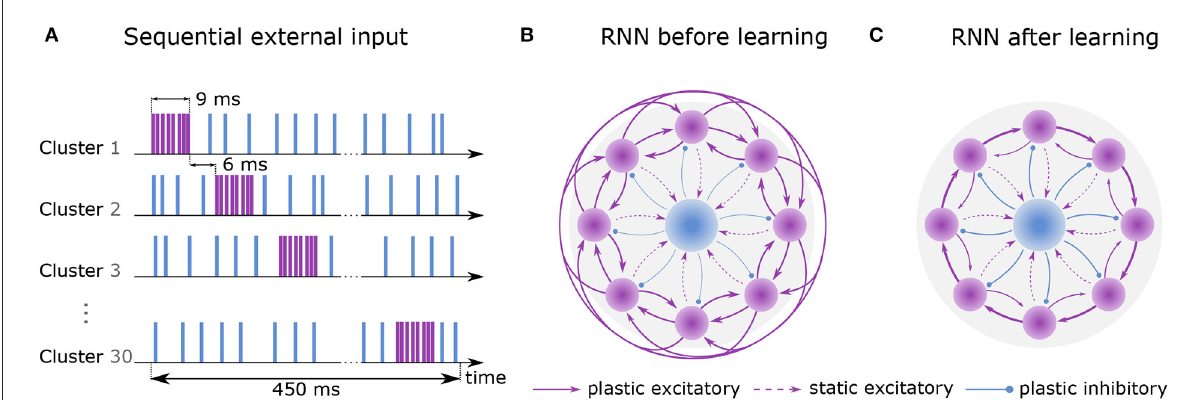
FIGURE1 Learning sequential dynamics. (A) External spike trains are sent to every excitatory neuron during the first hour of learning (sequential input). Excitatory and inhibitory stimulus are depicted in purple and blue, respectively. Each cluster is excited sequentially for 9 ms at a rate of 22.5k spks / sec (purple) and inhibited at a rate of 4.5k spks / sec otherwise (blue). The activation of the next cluster is preceded by 6 ms. Here, one round of sequential input takes 450 ms, which is dependent on the number of clusters ( N C = 30). (B) Recurrent network before learning. Purple circles represent excitatory clusters, each consisting of 80 excitatory neurons. For visual clarity, only 8 clusters are shown rather than 30. Blue circle represents 600 inhibitory neurons. Dashed arrows represent static connections; solid arrows represent plastic connections. Every connection of a particular connection type has the same synaptic weight. (C) After 2 hours of training, the recurrent network develops strong connections between cluster i and cluster i + 1 and weaker connections between cluster i and cluster i − 1. Connections to other clusters are vanishingly